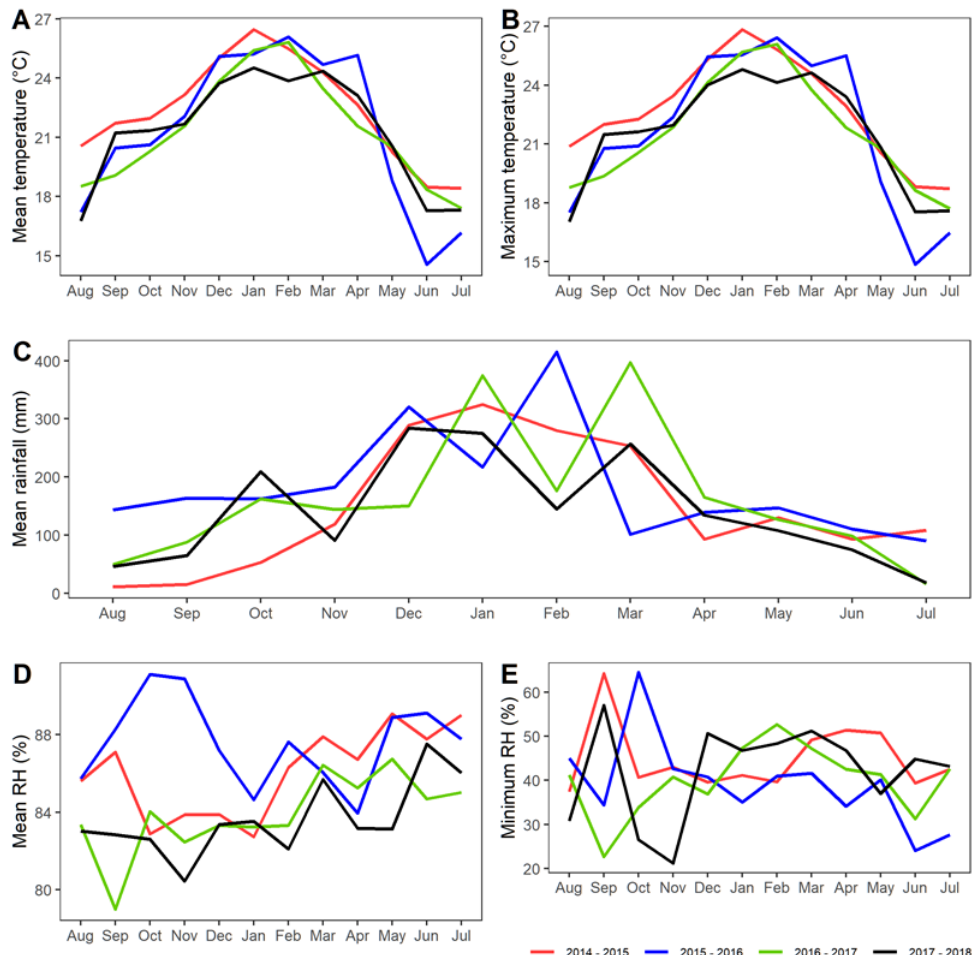
Figure 6. Temporal variation monthly in the average temperature ( A ), average maximum tempera- tures ( B ), average rainfall ( C ), average relative humidity ( D ), average minimum relative humidity ( E ) in the region of Morretes, Paraná, Brazil. Only the periods of 2014 – 2015 and 2015 – 2016 differed from the others regarding the monthly average relative humidity (post-hoc pairwise comparison test; see text).